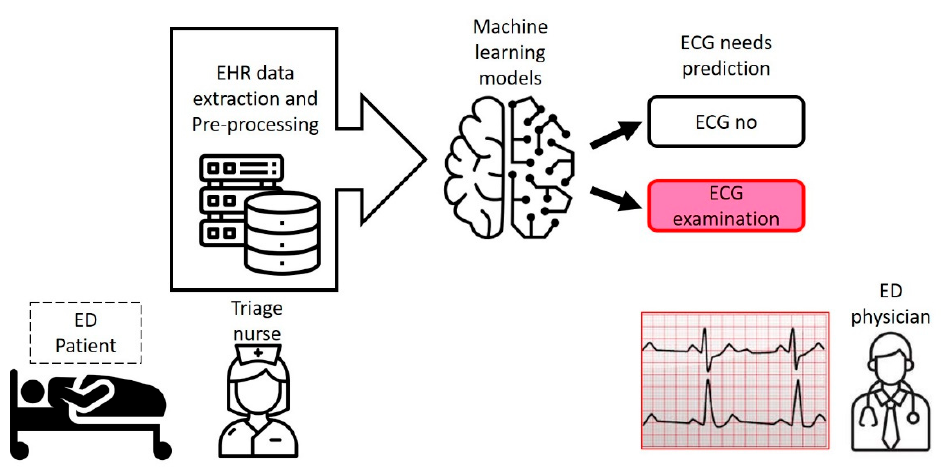
Figure 6. Scheme of machine learning models for ECG decision support at ED triage.